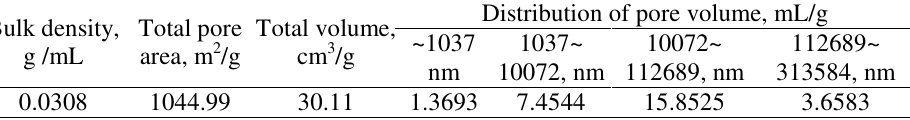
Table 1 . Structural parameter of EG